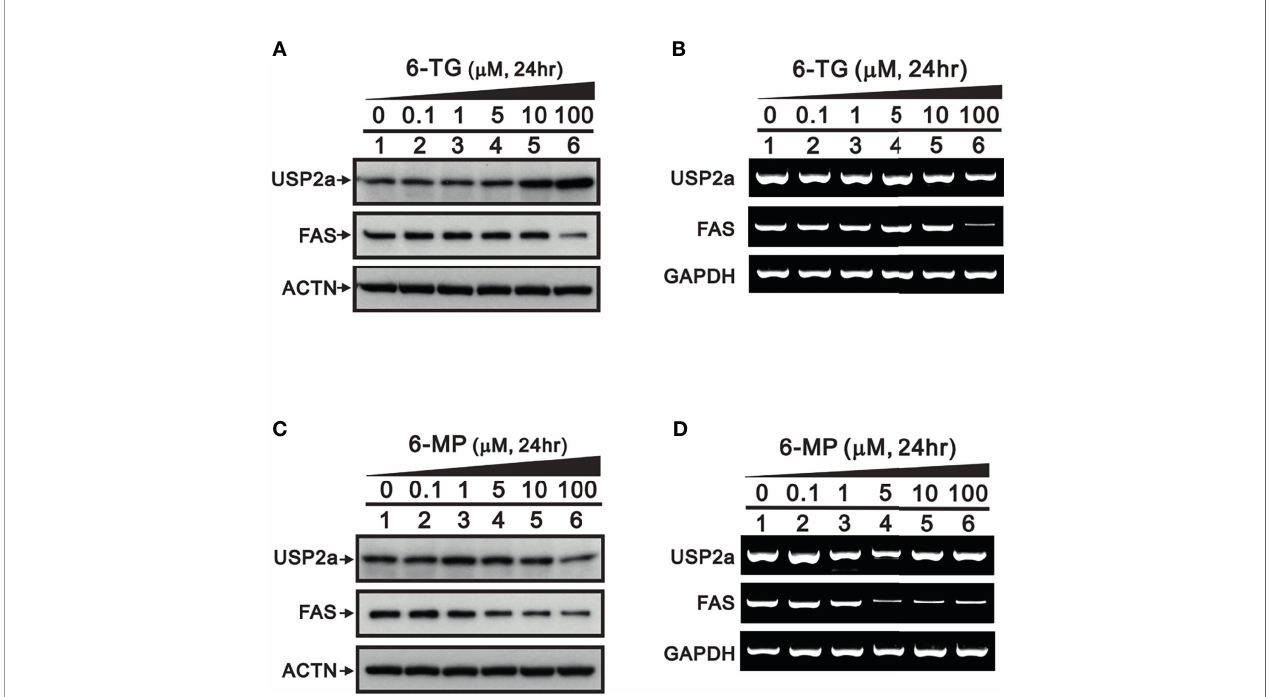
FIGURE 3 | Dose-dependent effects of 6-TG and 6-MP on expression of USP2a protein and mRNA in A253 cells. Cells were treated for 24 h with the indicated concentration of 6-TG (A, B) or 6-MP (C, D) , after which cell lysates were subjected to (A, C) Western blotting analysis with antibodies against USP2a and FAS; or (B, D) RT ‐ PCR analysis for USP2a and FAS mRNAs. ACTN is a protein loading control; GAPDH is an mRNA loading